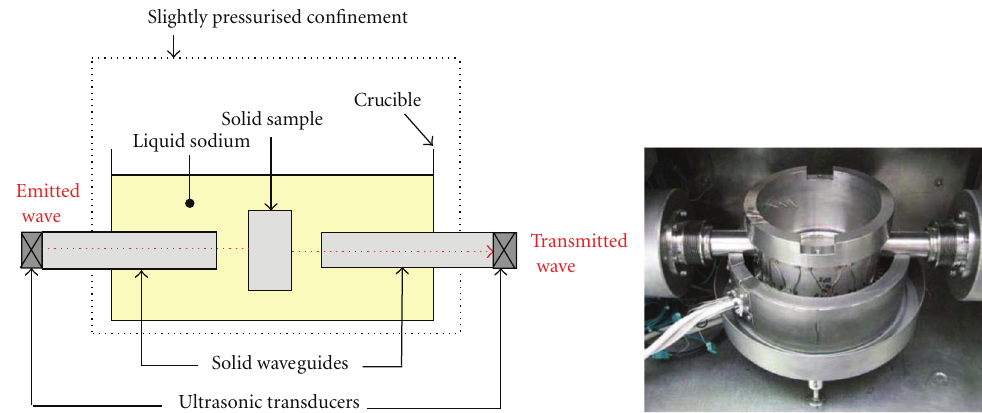
Figure 17: Schematic view of the acoustic path of Liquidus device and view of the facility (with 210mm diameter sodium pot).